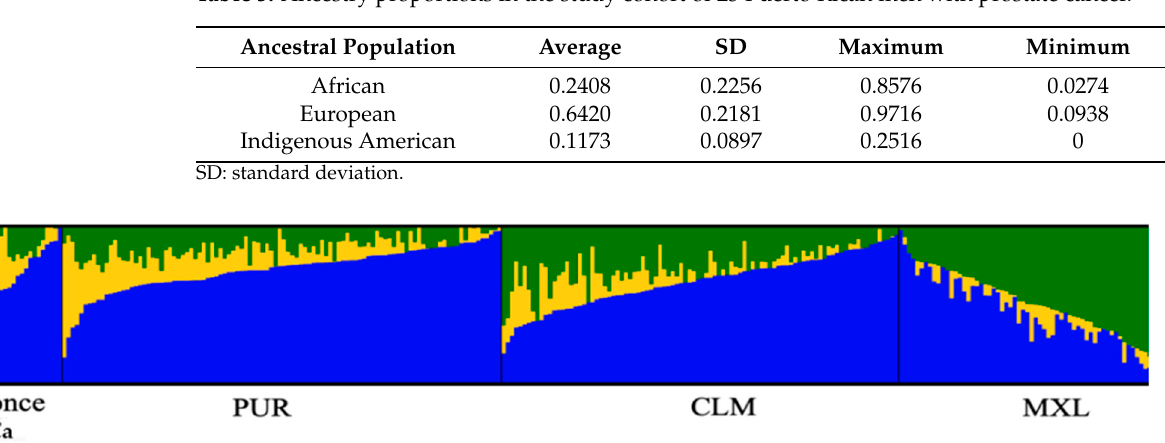
Figure 3. Two differentially methylated DNA repair genes associated with aggressiveness were found to contain probes with significant changes in methylation. GSM plots for ( A ) JMJDC1 and ( B ) RNF169 are shown.